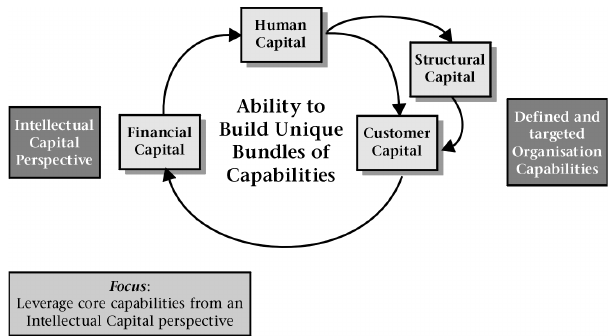
Figure 3: A View on Leveraging Core Capabilities from an Intellectual Capital